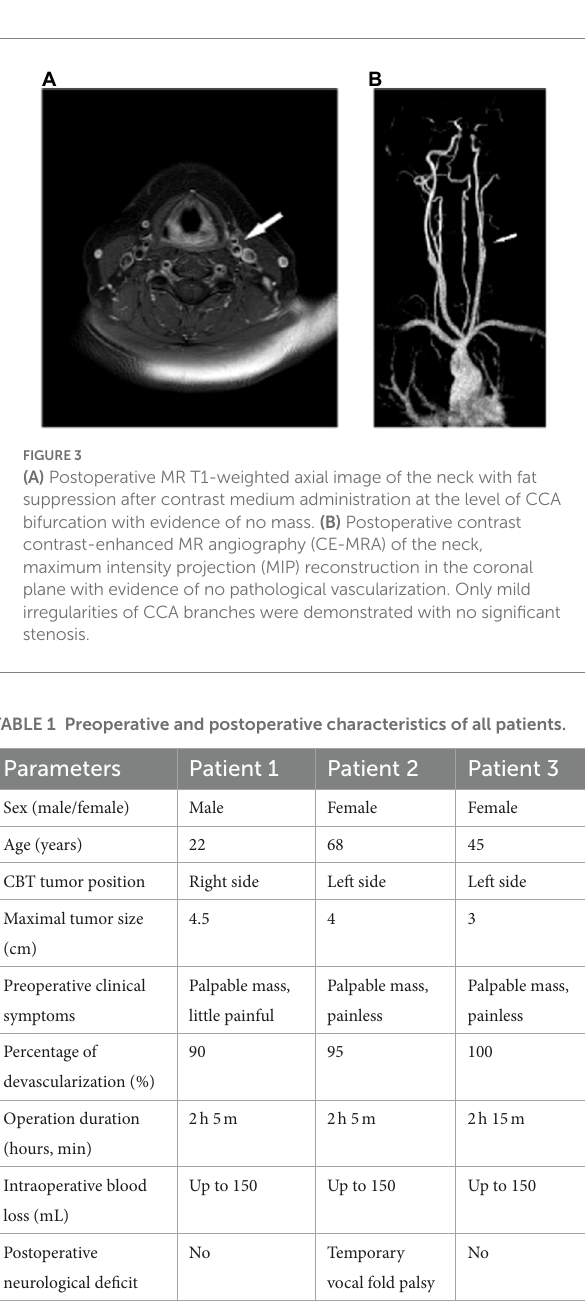
Palpable mass, little painful